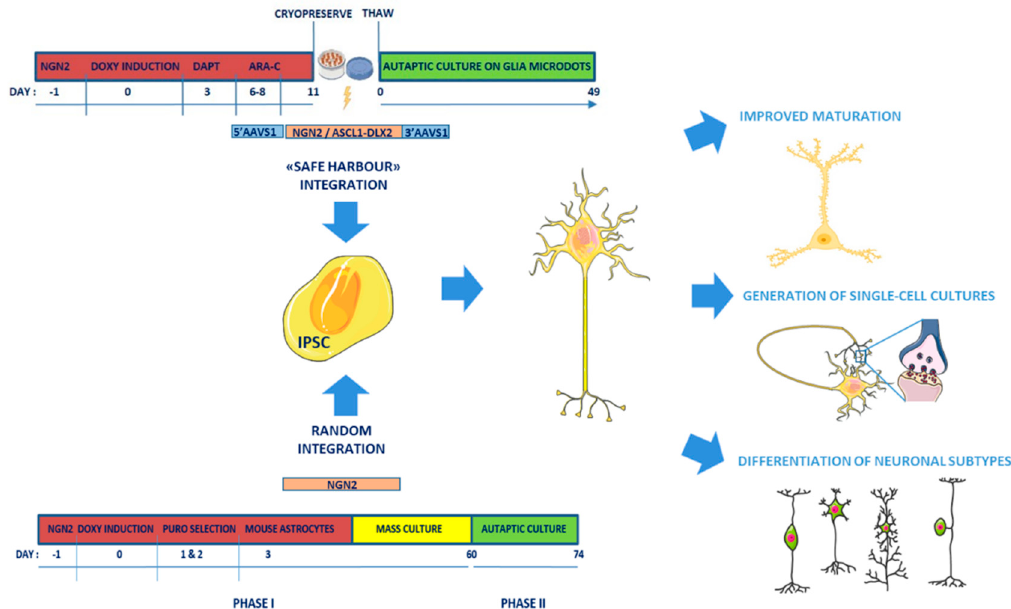
Figure 1. Single-cell approaches to generate mature human neurons from induced Pluripotent Stem Cells (iPSCs) to study synapse function. Overview of the new culture protocols (safe harbor integration [68,69] or random integration/two phase protocol [67]) for generating mature human neurons from iPSCs to study the morphological and functional parameters underlying human synaptic transmission in specific neuronal subtypes.